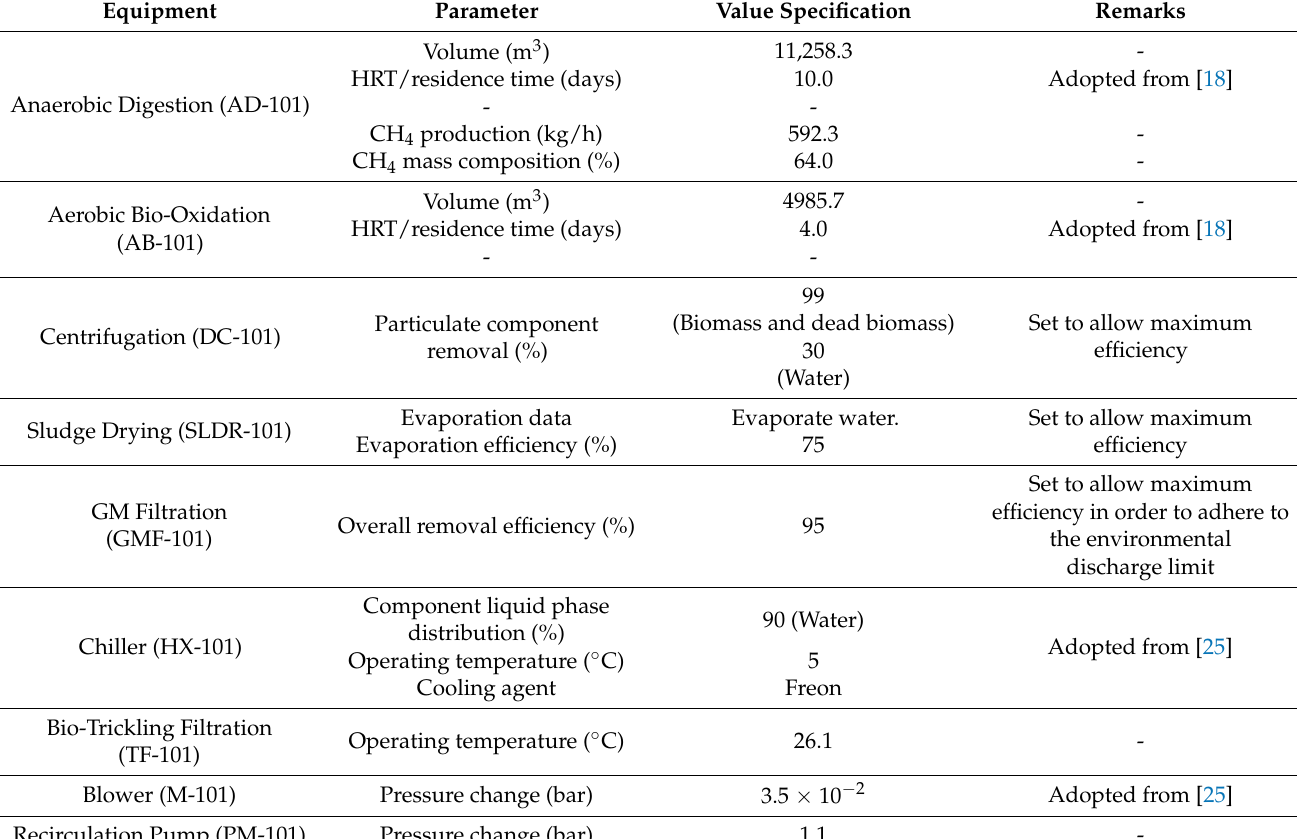
Table A4. An overview of simulated equipment setup and related specification. Note: Other parameters not specified is claimed to be as per SuperPro Designer V9 default settings.